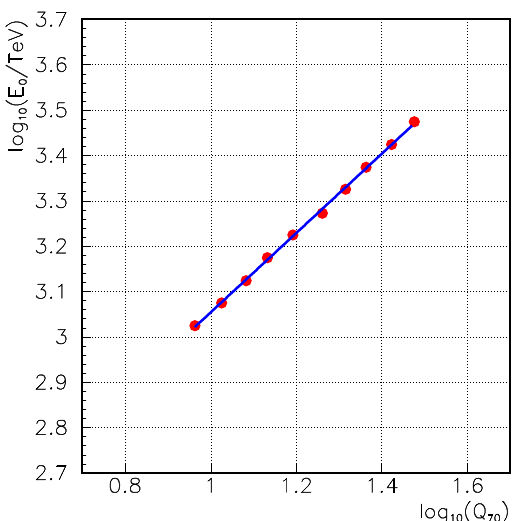
Figure 7. Experimental correlation of Q 70 and